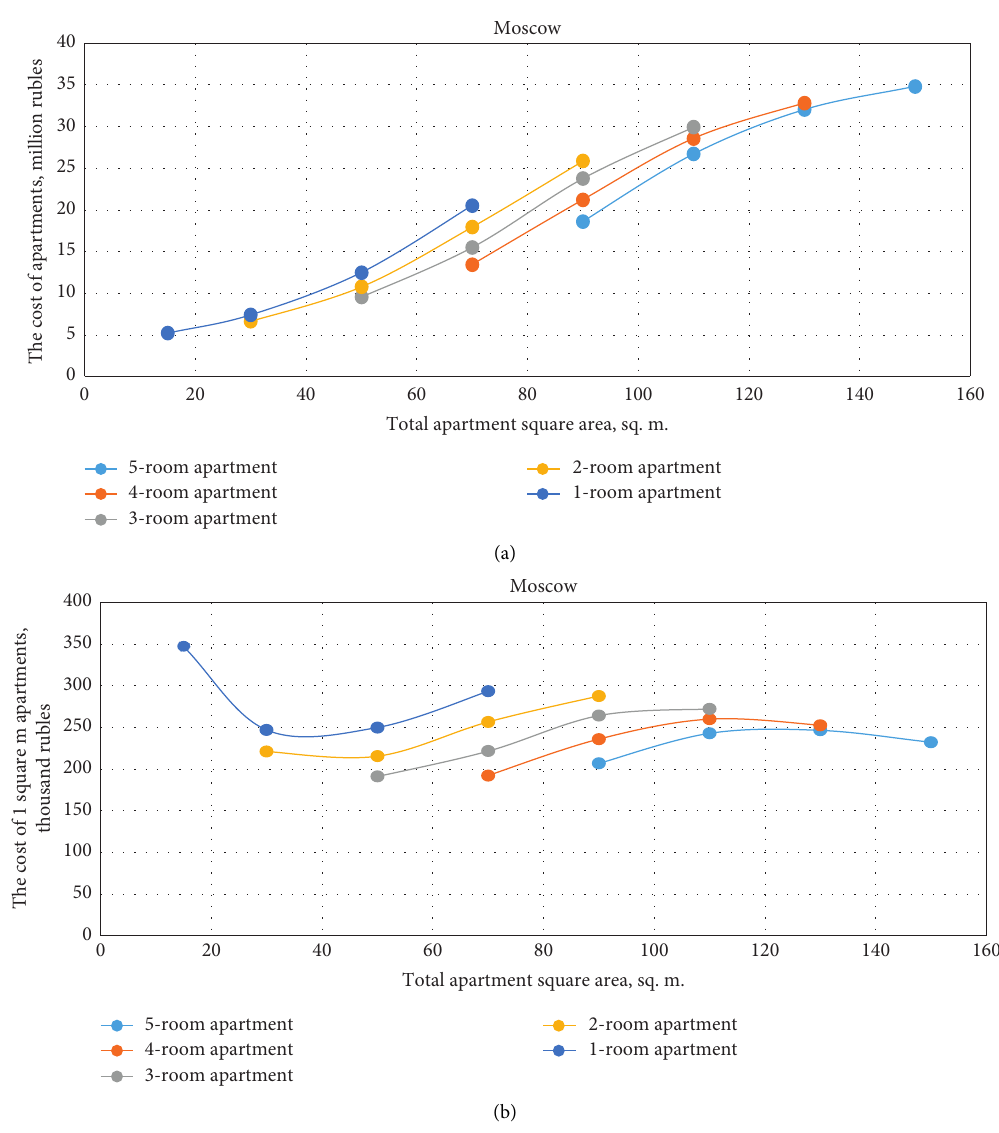
Figure 4: Influence of the square area of Moscow apartments on their cost (a) and on the unit cost of one square meter